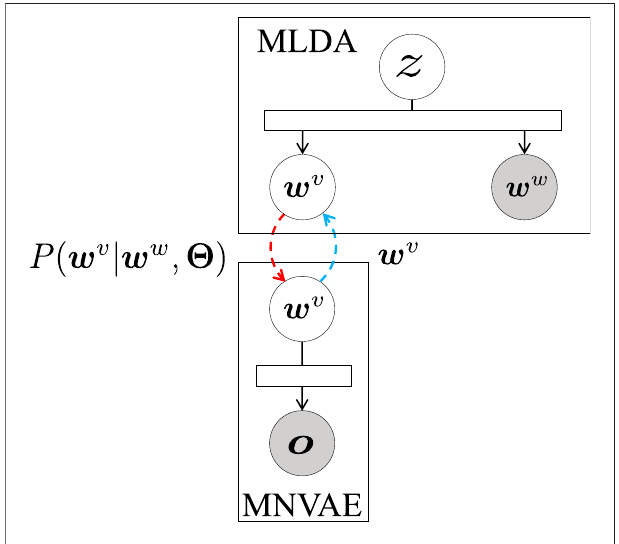
FIGURE 3 | Exchange of parameters between MNVAE and